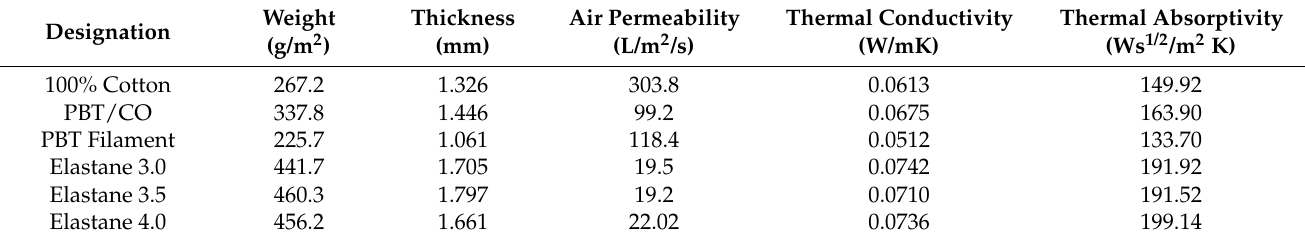
Table A3. The air permeability, the thermal comfort, weight, and thickness values of the fabric